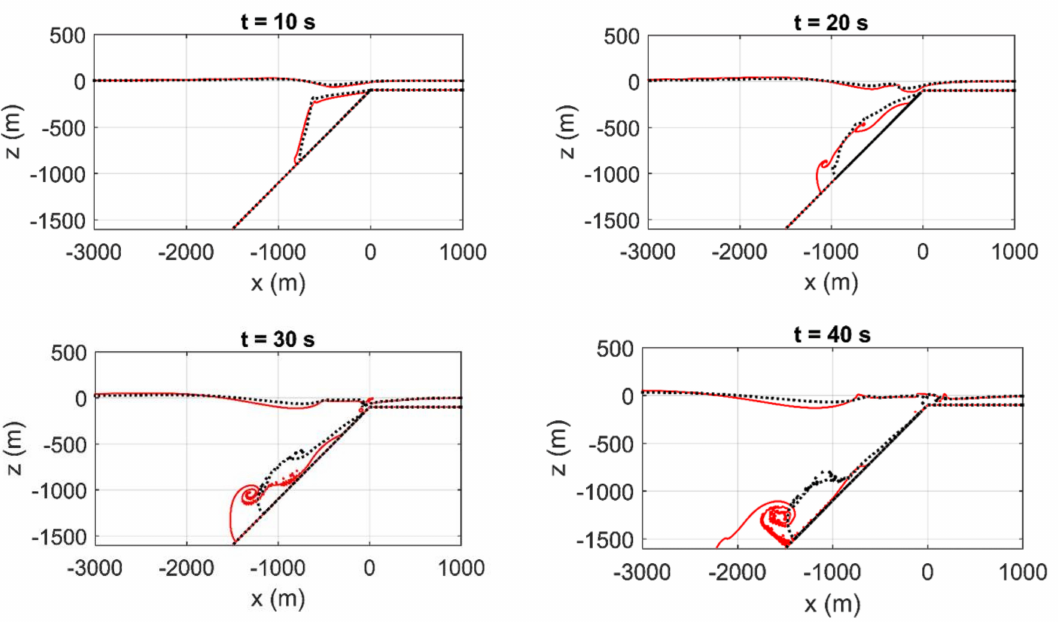
Figure 12. The snapshots of predicted water free surface and slump profile of scale H 4 with (cid:16) (cid:17) (cid:16) µ µ τ = 10 10 , 50, 1000 y B , A , black